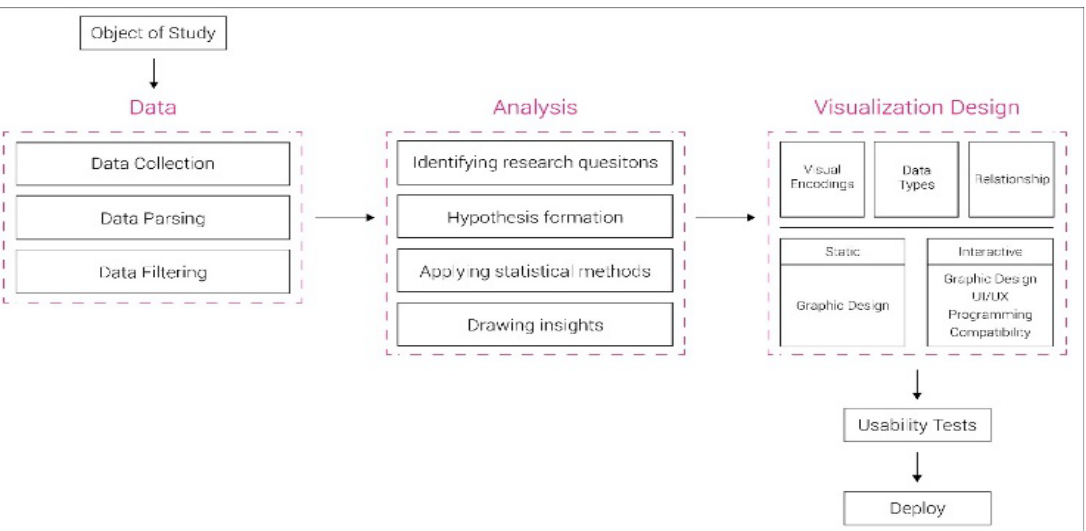
Figure 3: Data Journalism